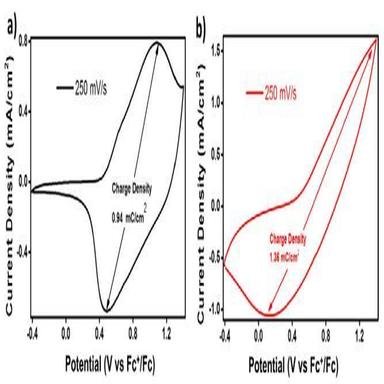
Cyclic voltammetry graphs of a) CH/p(BT) b) CH/rGO/p(BT).